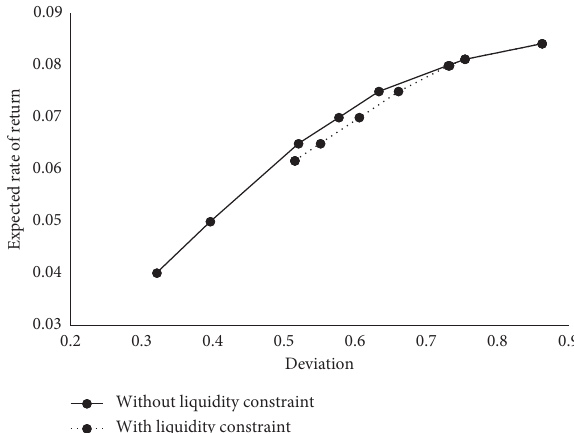
Figure 2: Some possibilistic efficient portfolios with and without liquidity